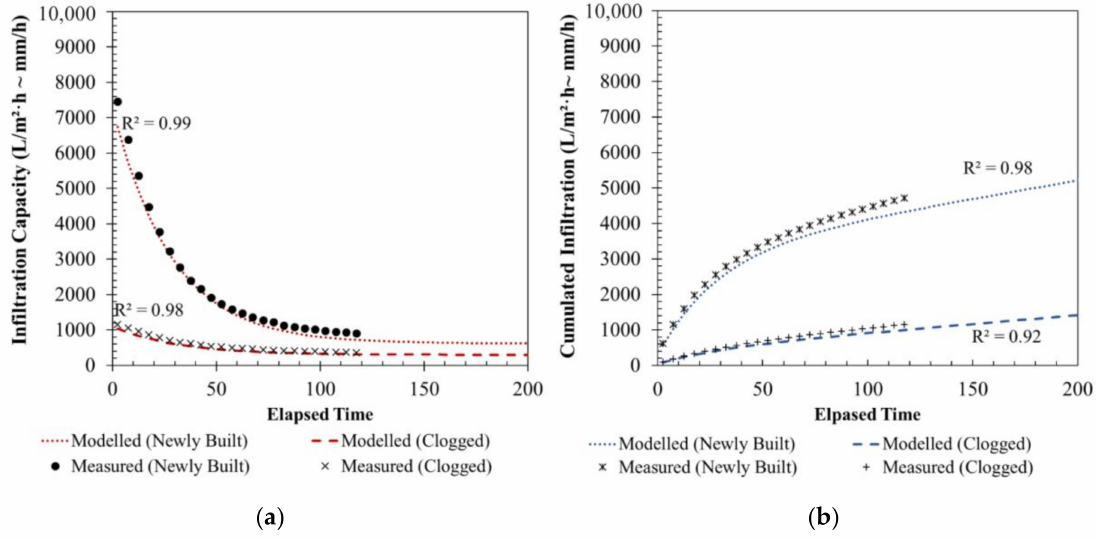
Figure 8. Horton infiltration model developed on the basis of the results obtained from LCS test results and the correlations established with LCH permeability tests in Figure 6: ( a ) infiltration rate and ( b ) cumulated infiltration according to the developed